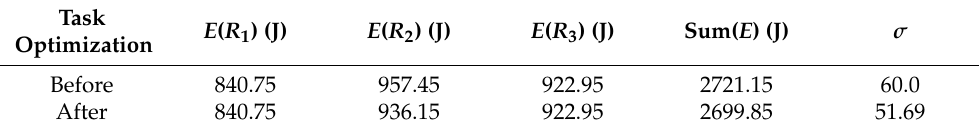
Table 6. Comparison of energy consumption before and after optimization from Experiment 4.